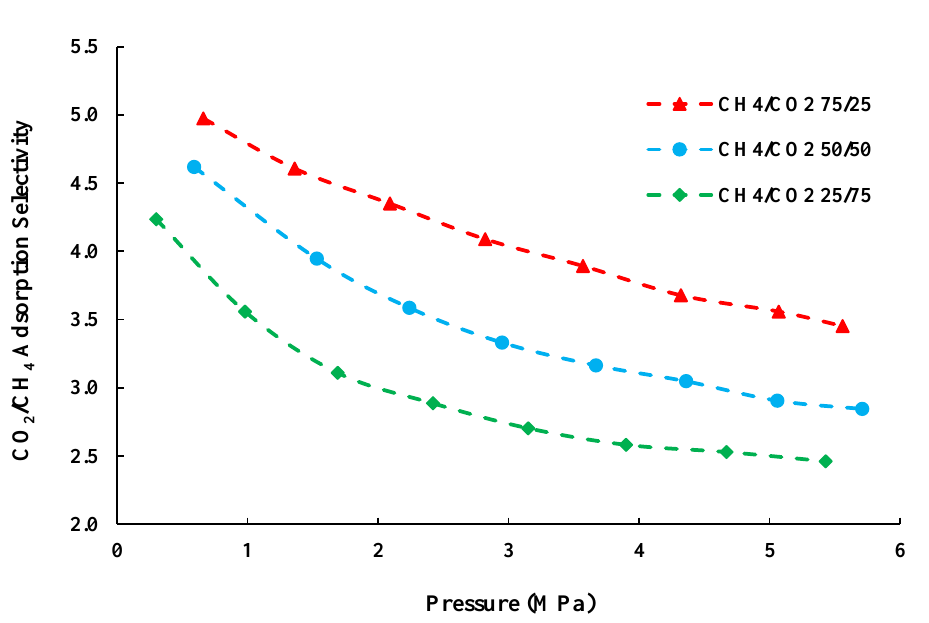
Figure 6. Adsorption selectivity of CH 4 /CO 2 binary mixtures at 313.15 K.